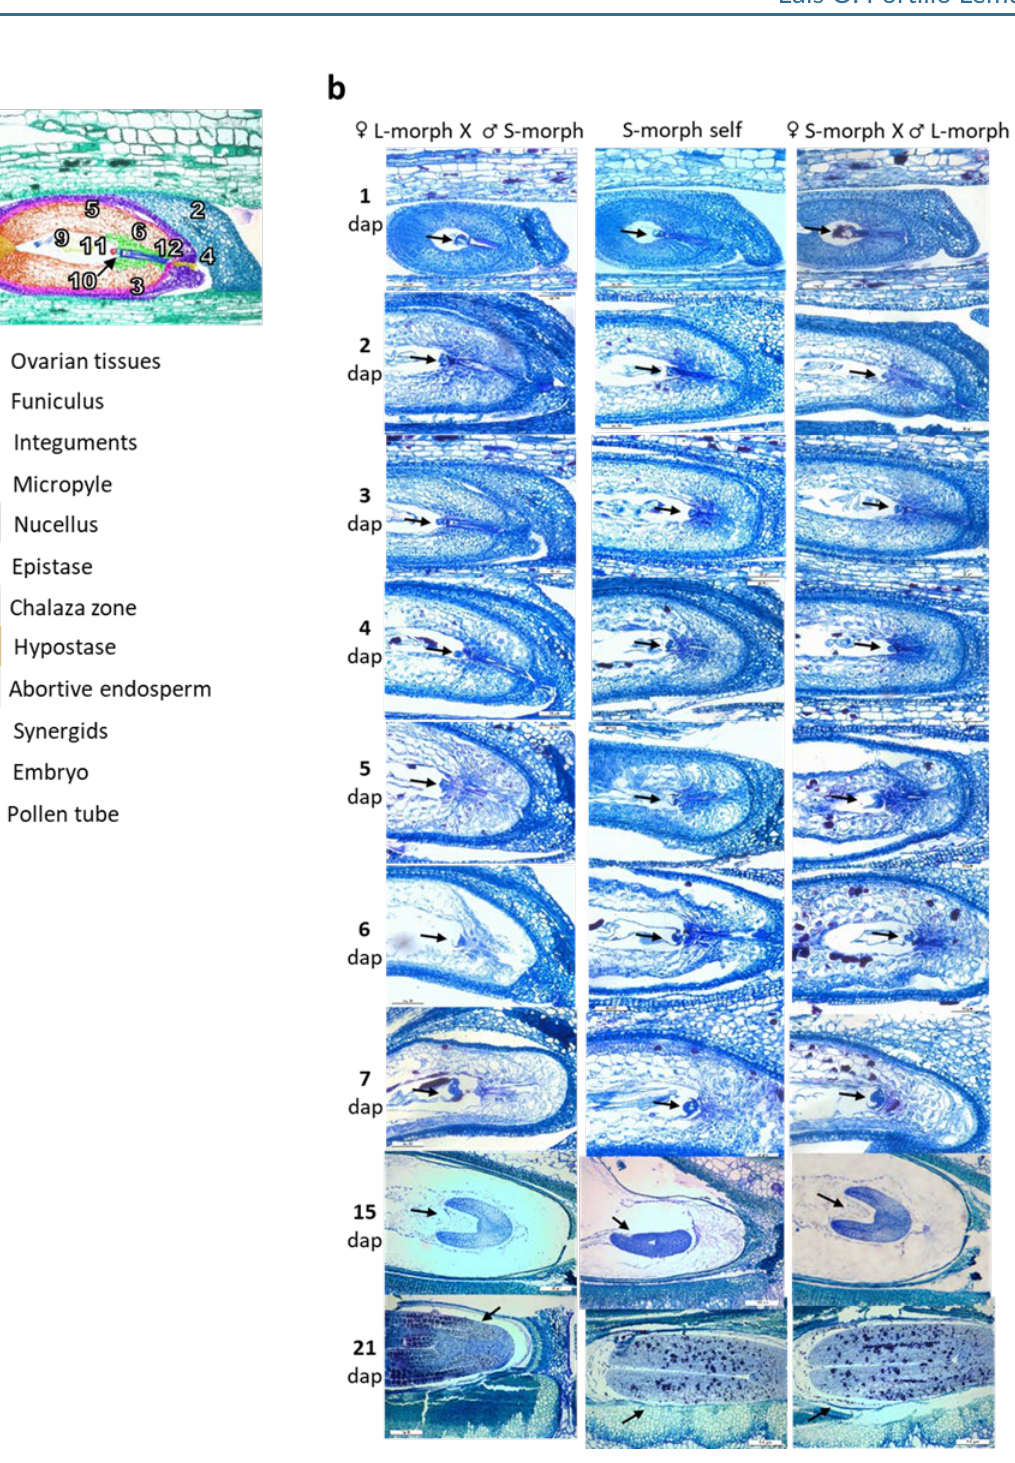
Figure 5: Fertilisation and embryonic development after cross and self-pollinating the self- incompatible L-morph and the self-compatible S-morph flowers. a) A comprehensive, colorized scheme of the different tissue parts of a L-morph ovule 3 days after disassortative pollination. b) Evolution of the ovules 1, 2, 3, 4, 5, 6, 7, 15, and 21 days after pollen deposition on the stigmas (dap): (1) L-morph ovules after cross-pollination ( ♀ L-m X ♂ S-m); (2) S-morph ovules after self-pollination; (3) S-morph ovules after cross-pollination ( ♀ S-m X ♂ L-m). The arrows indicate the development of embryo. All sections were stained with toluidine blue O, 20X zoom under optical